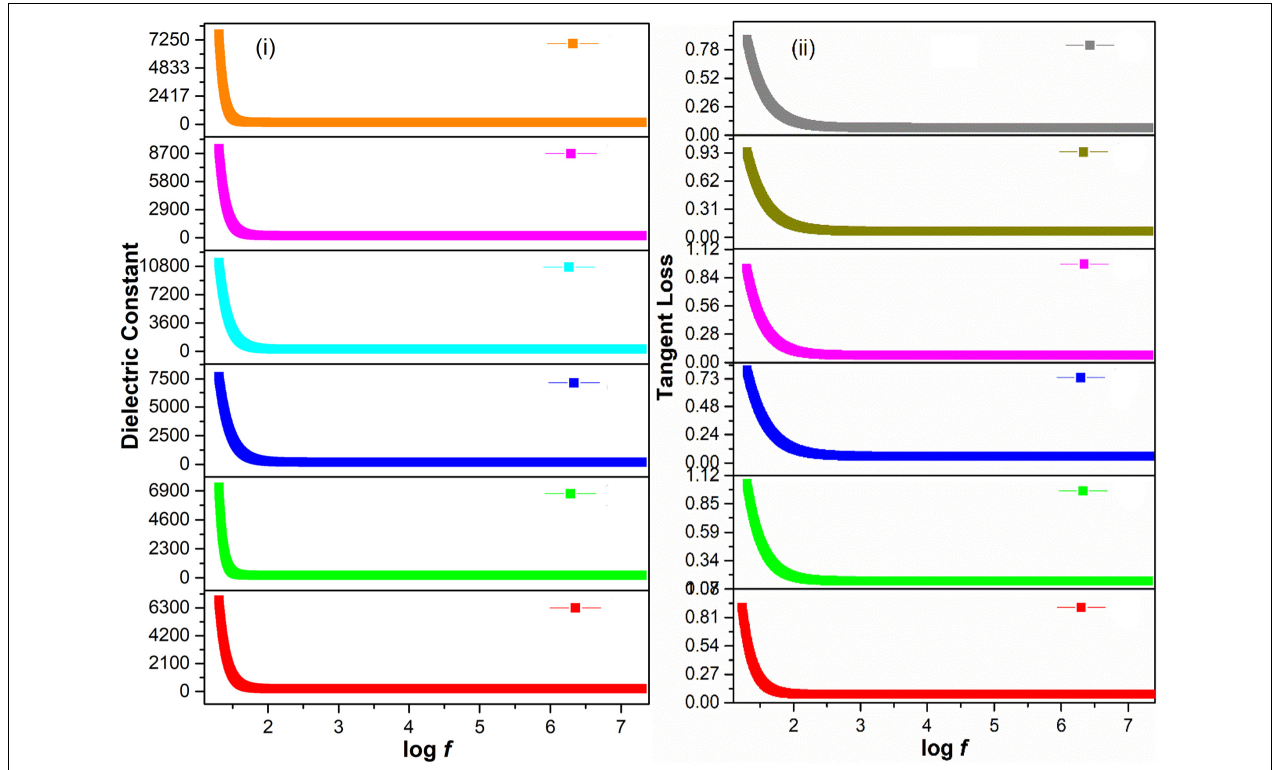
FIGURE 4 | (i) Dielectric constant and (ii) Tangent loss of green-synthesized IONPs by (A) PJ, (B) WV, (C) PP, (D) BC, (E) AP, and (F) As extracts.